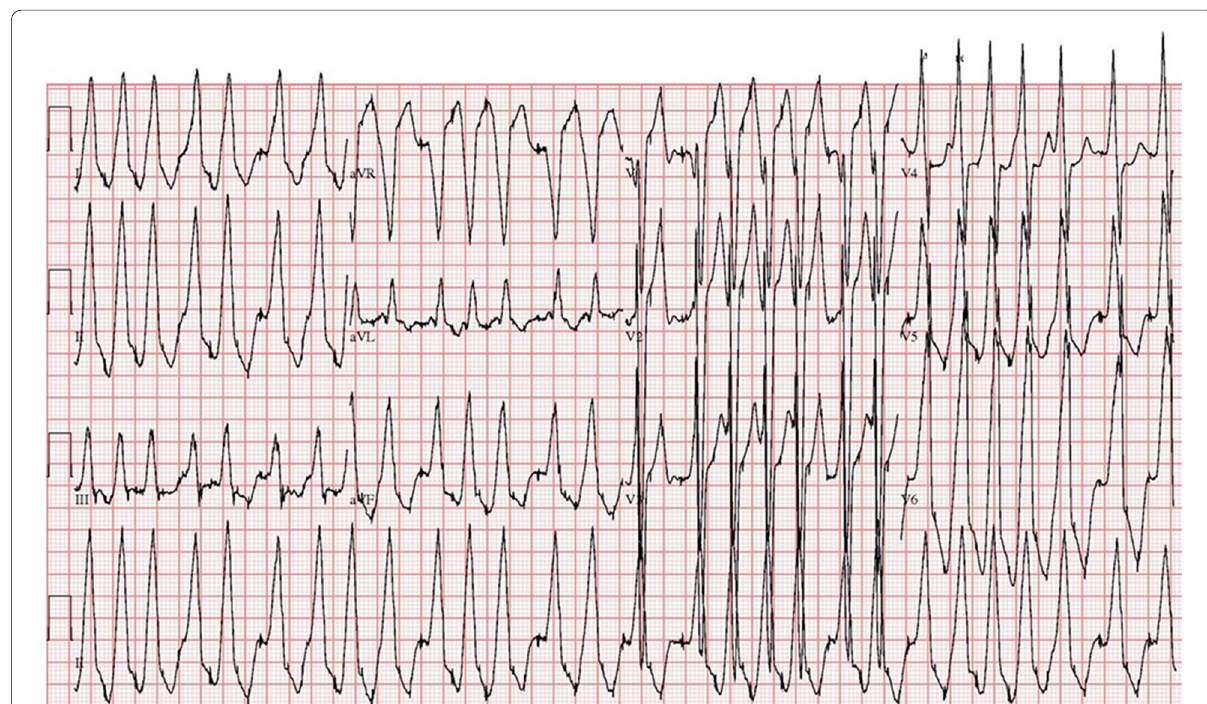
Fig. 1 Electrocardiogram showed irregular wide QRS tachycardia (normal QRS axis, left bundle branch block morphology and R/S transition at